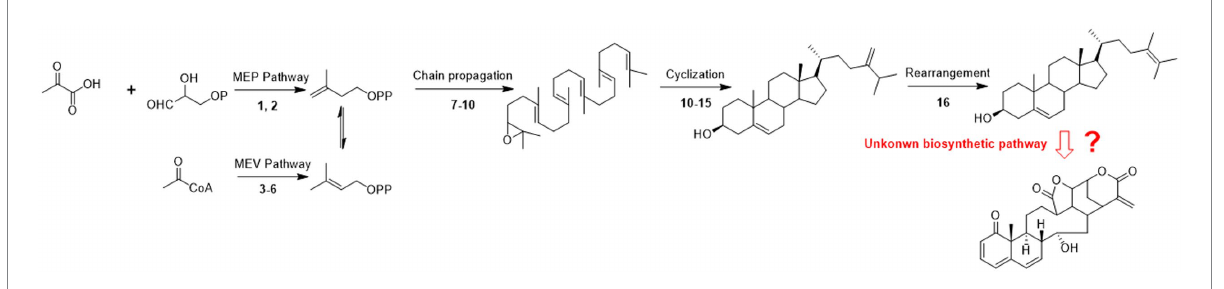
FIGURE 2 Possible pathways of physalin biosynthesis in previous studies. 1-deoxy-d-xylulose-5-phosphate synthase; (2) 1-deoxy-d-xylulose-5-phosphate reductase; (3) 3-hydroxy-3-methylglutaryl-coenzyme A reductase; (4) mevalonate kinase; (5) phosphomevalonate kinase; (6) mevalonate diphosphosphate decarboxylase; (7) farnesyl diphosphate synthase; (9) squalene synthase; (10) squalene epoxidase; (11) cycloartenol synthase; (12) sterol methyl transferase 1; (13) sterol-4 α -methyl oxidase 1; (14) cycloeucalenol cycloisomerase; (15) obtusifoliol-14-demethylase; sterol-4 α - methyl oxidase 2; (16) stero- Δ -24-isomerase.